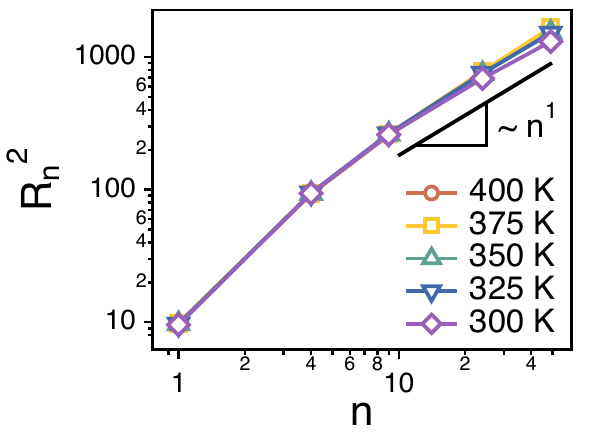
Figure 2. Simulation results for the end-to-end distance ( R n ) of strands of size n at different tempera- tures. A solid line is a guide with an exponent of